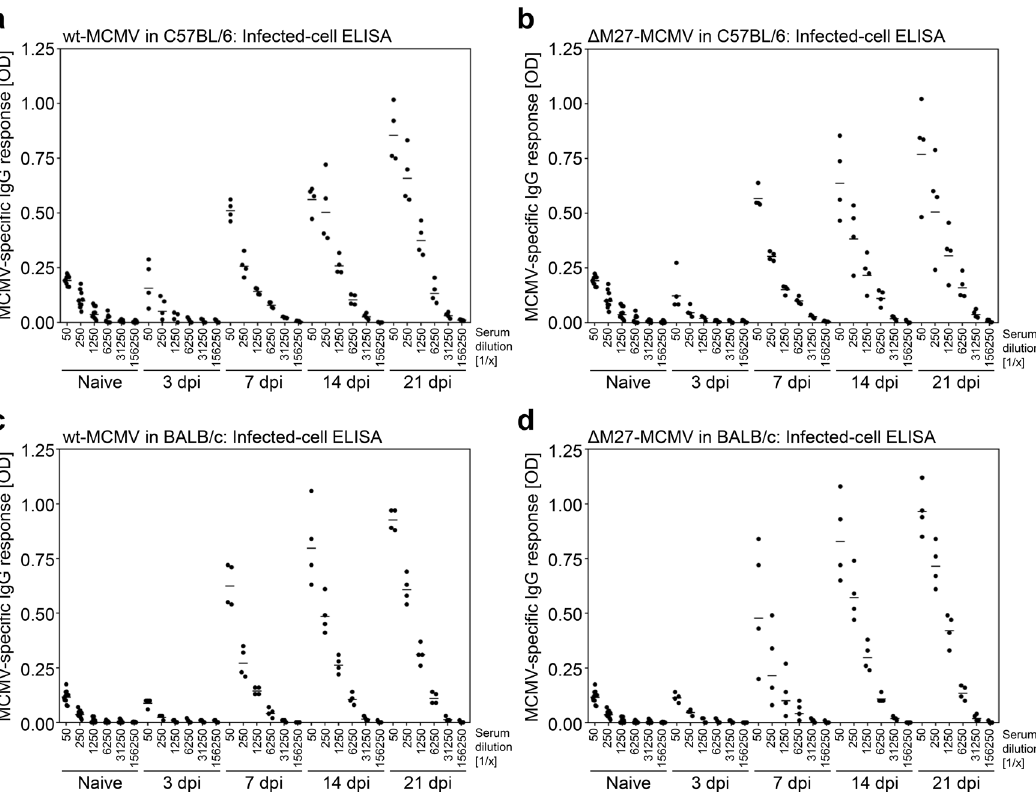
Fig. 2 Immunization with Δ M27-MCMV induces MCMV-speci fi c antibodies recognizing infected cell proteins. C57BL/6 ( a , b ) and BALB/c ( c , d ) mice were infected i.p. with wt-MCMV or Δ M27-MCMV. At 3, 7, 14, and 21 dpi, serum samples were collected. MCMV-speci fi c IgG antibodies recognizing MCMV-infected cell proteins were quanti fi ed by ELISA using indicated serum dilutions. All ELISA measurements were performed in triplicates. Shown is the mean for each mouse. Sera of naïve animals served as control. The geometric mean values (horizontal bars) as well as the values of individual mice ( n = 4 per group) are